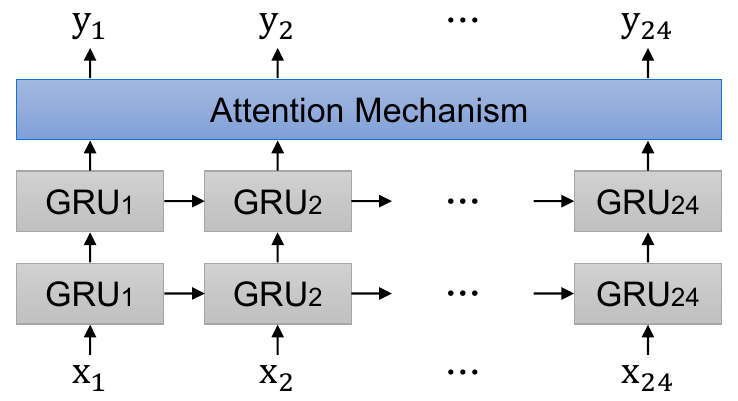
Figure 3. Attention based GRU model architecture.